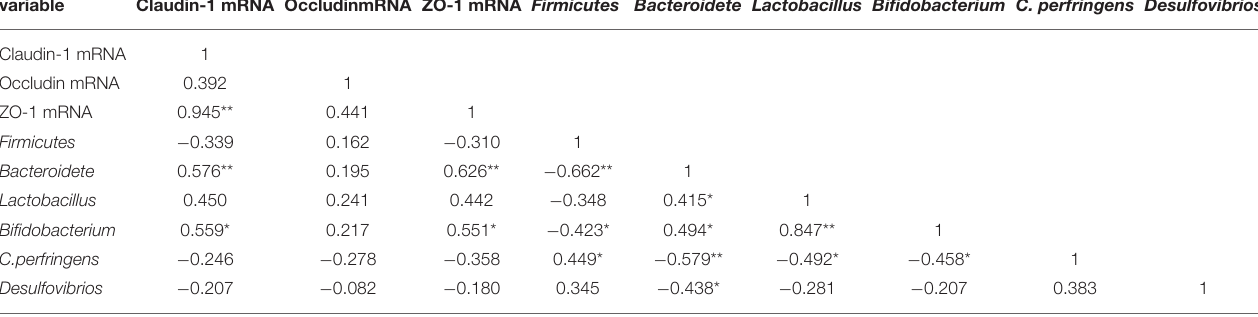
TABLE 4 | Correlation analysis of intestinal barrier and intestinal microbes. variable